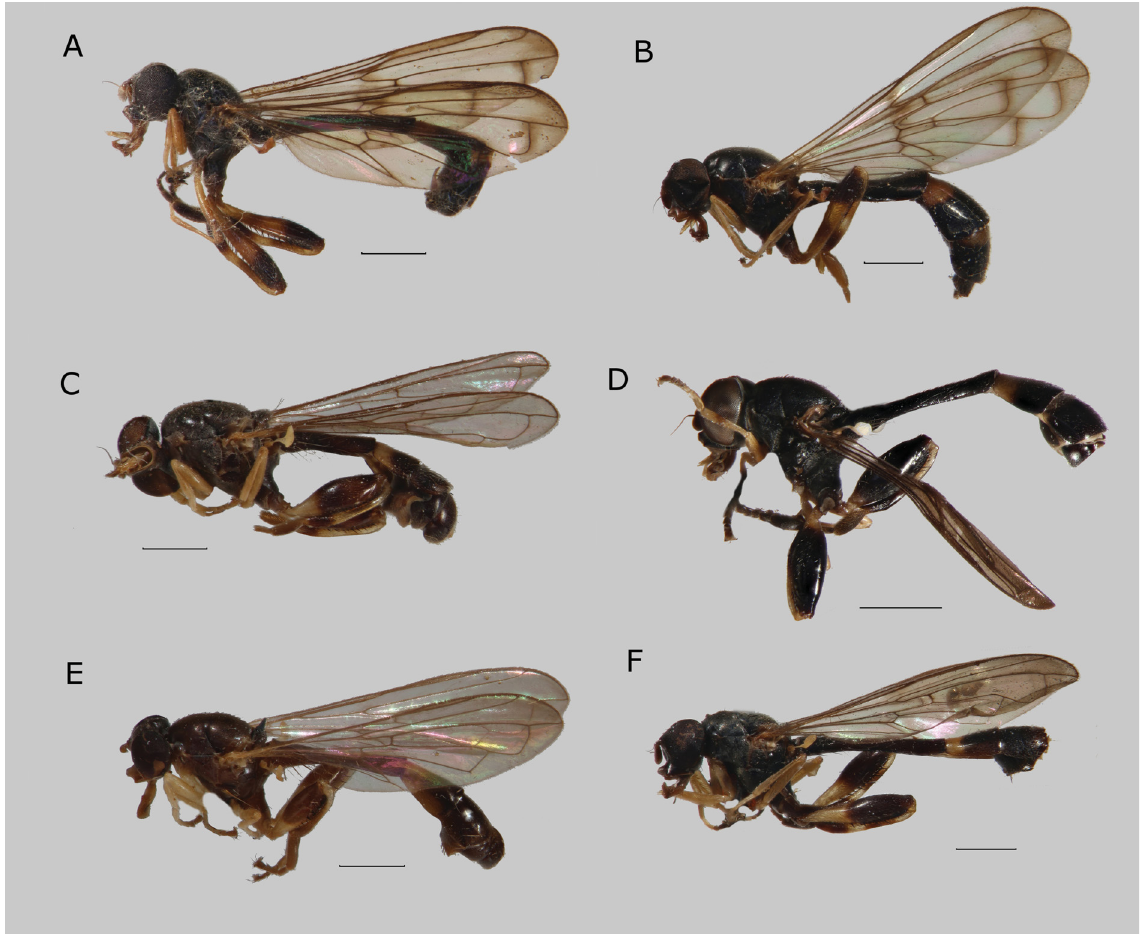
Fig. 75. Habitus, lateral view. A . Sphegina (Asiosphegina) plau tus sp. nov., paratype, ♂ ,